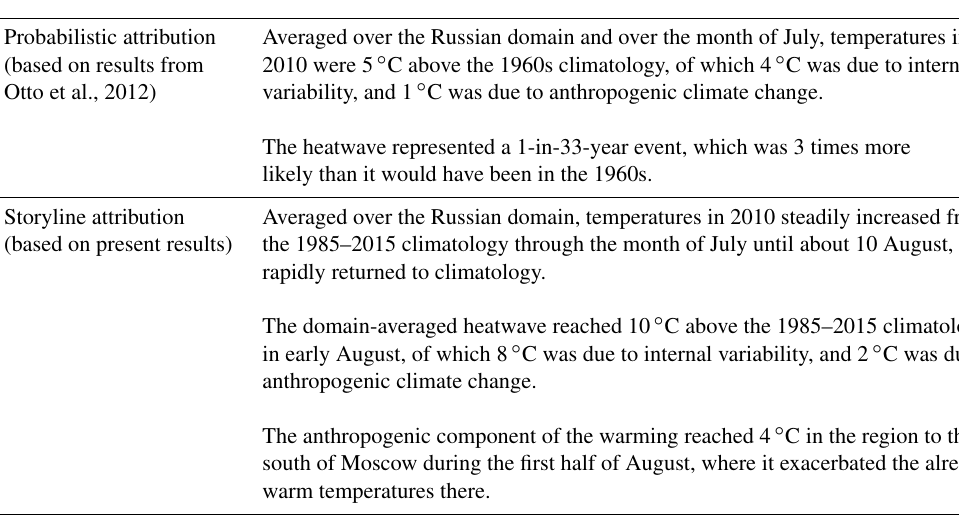
Table 2. Example of attribution statements that are possible using the probabilistic and storyline approaches for the case of the 2010 Russian heatwave. Probabilistic